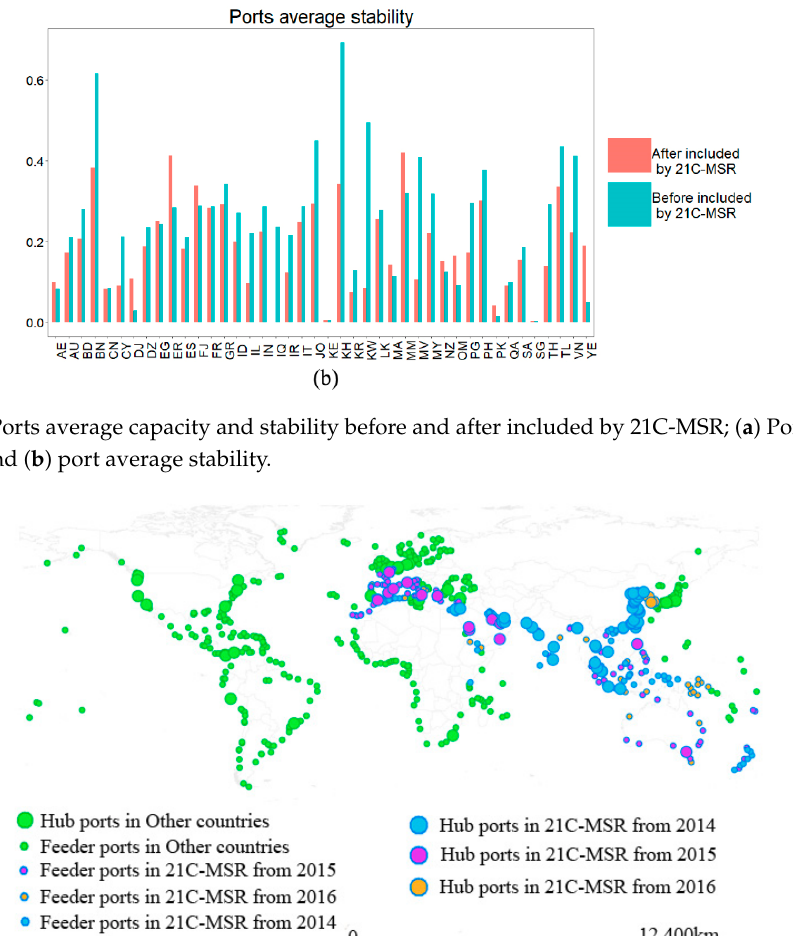
Figure 7. Ports average capacity and stability before and after included by 21C-MSR; (a) Port average capacity and (b) port average stability.